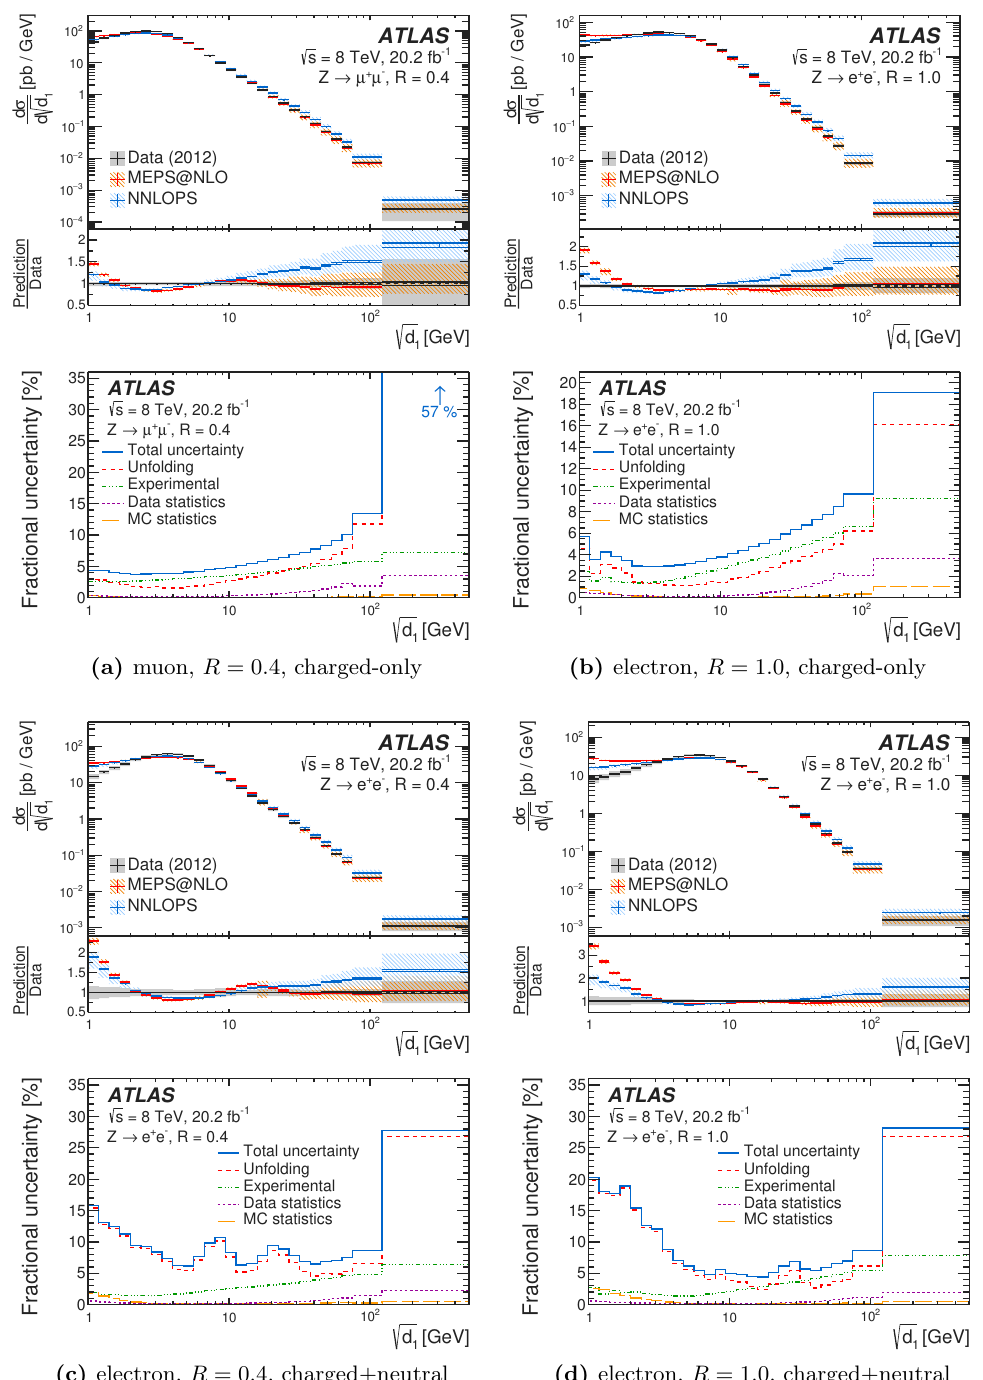
p Figure 5. Unfolded d 1 splitting scale for four di(cid:11)erent variations of the analysis as described in the sub-captions. The upper panels show the distributions in the same style as (cid:12)gure 4. The lower panels show breakdowns of the systematic uncertainties in data in the same style as (cid:12)gure